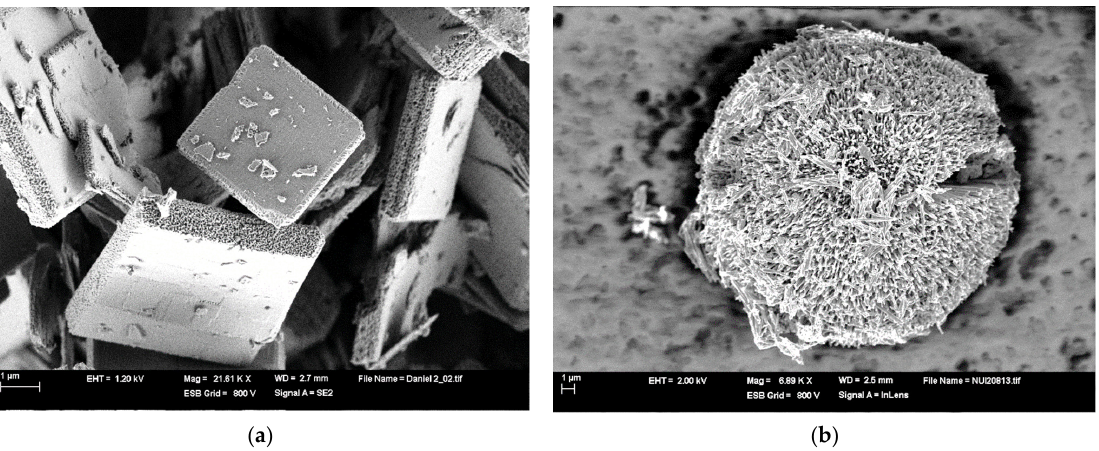
Figure 10. SEM micrographs of defected vanadium oxide (NH 4 ) 2 V 7 O 16 micro-squares (VOx-MSQ): ( a ) general view of clustered and eroded VOx-MSQ featuring borders with high porosity degree; ( b ) cracked (C 18 H 35 NH 3 ) 2 V 7 O 16 nanourchins (VO x